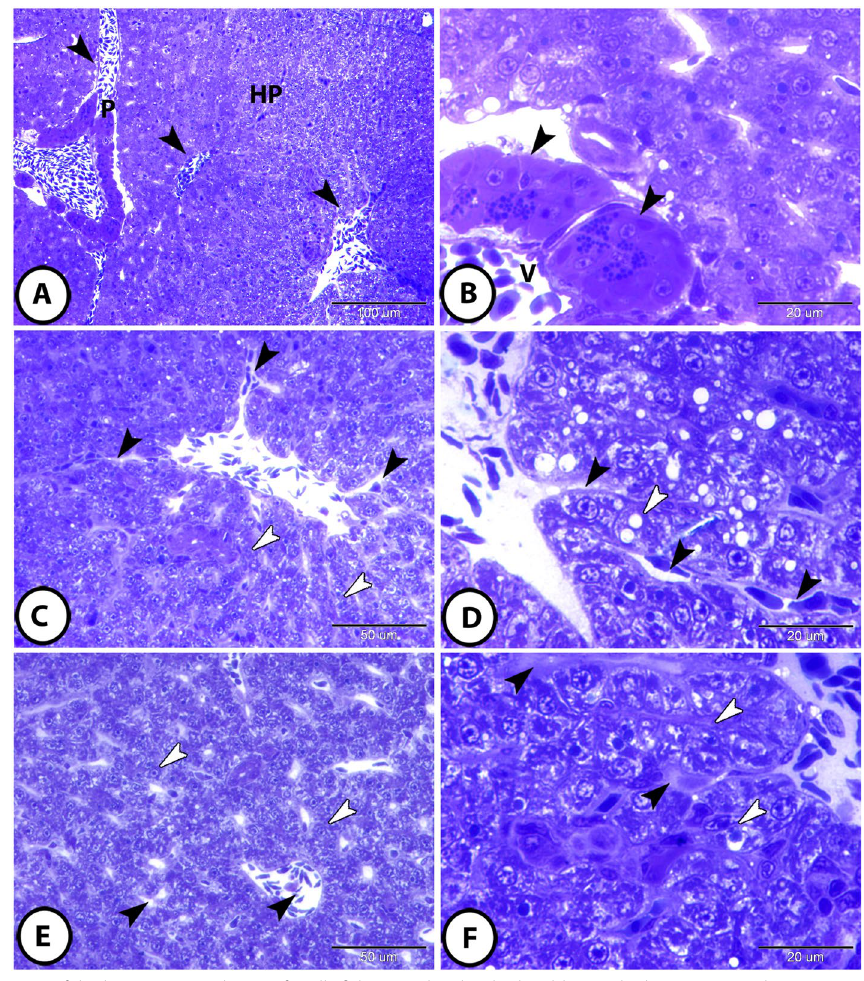
Fig. 1 Semithin sections of the hepatic parenchyma of molly fish stained with toluidine blue. A The hepatic parenchyma (HP) was interrupted with islands of connective tissue that enclosed the hepatic vascular and biliary components (arrowheads) and pancreatic tissue (P). B The pancreatic tissue appeared as clusters of hepatopancreatic acini that were composed of groups of serous cells (arrowheads) encircling a vein (V). C and D The hepatic parenchymal arrangement showed cord-like form; most hepatocytes (white arrowheads) were arranged in simple layers and the hepatic sinusoids (black arrowheads) were relatively straight and enlarged. E and F The tubular form: many hepatocytes (white arrowheads) were arranged in double layers and the hepatic sinusoids (black arrowheads) were relatively narrow and irregular in